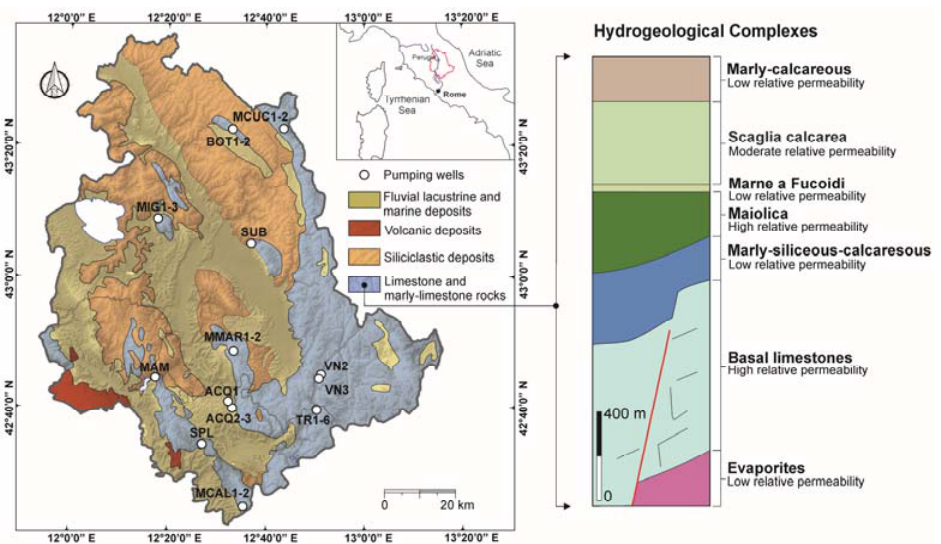
Figure 1. Lithological map of the Umbria region (central Italy) with wells in fractured and karstified carbonate aquifers. Table 1. Main characteristics of pumping wells in the fractured carbonate aquifer in the Umbria region. The location of wells is in figure 1.